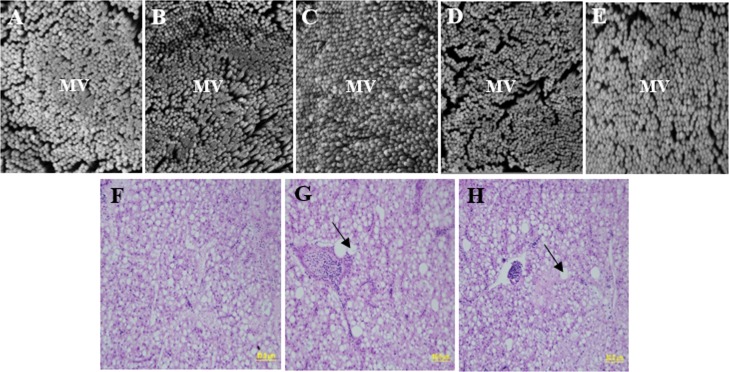
Gut microvilli and liver histological structure of juvenile barramundi.High magnification (x 30,000) electron micrographs showing microvilli in the distal gut of juvenile barramundi fed five experimental diets control, 75PBM, 75BPBM, 100PBM and 100BPBM (Panel A-E). MV = microvilli, Scale bar = 2 μm, microvilli density count per μm2. Histological structure of the liver of juvenile barramundi fed control, 100PBM and 100BPBM diets (Panel F-H). Black arrow in liver micrographs indicates large vacuoles in hepatic cells (H&E staining, 400x magnification, scale bar = 50μm).